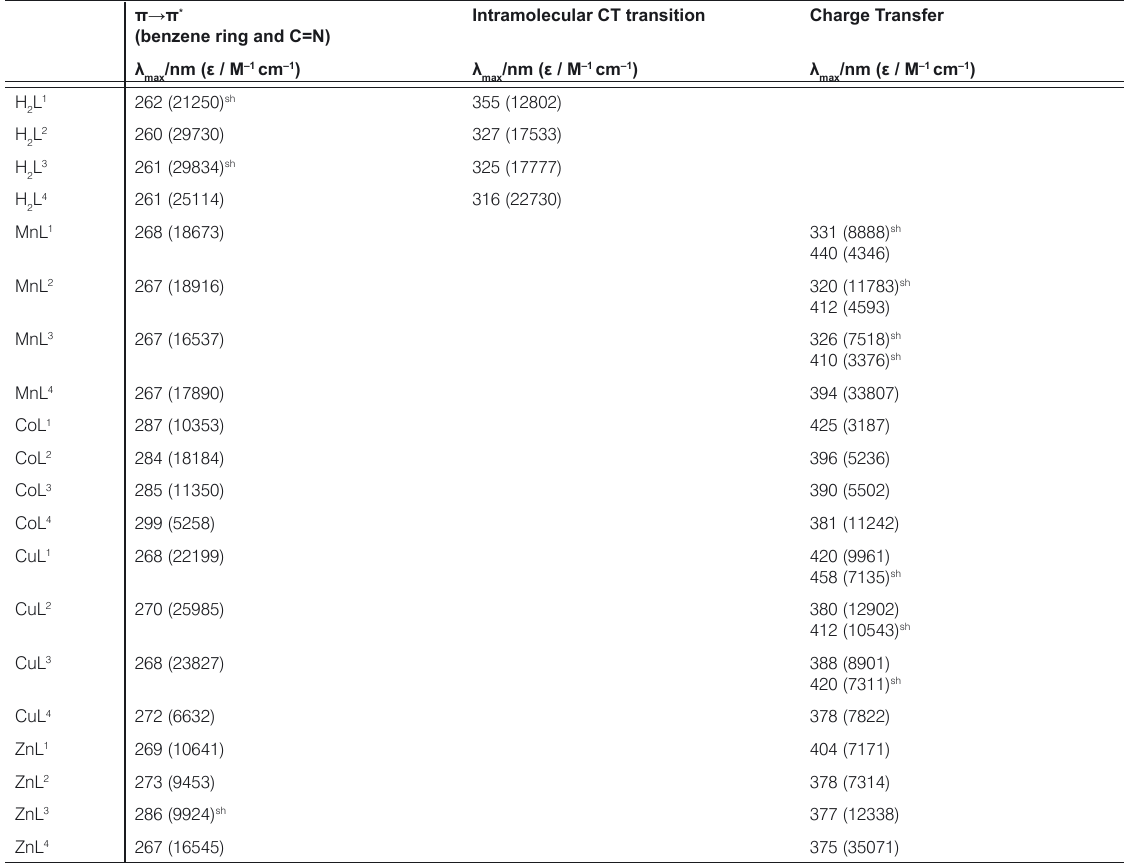
Table 3. Electronic spectra data of Schiff bases and their complexes in DMF